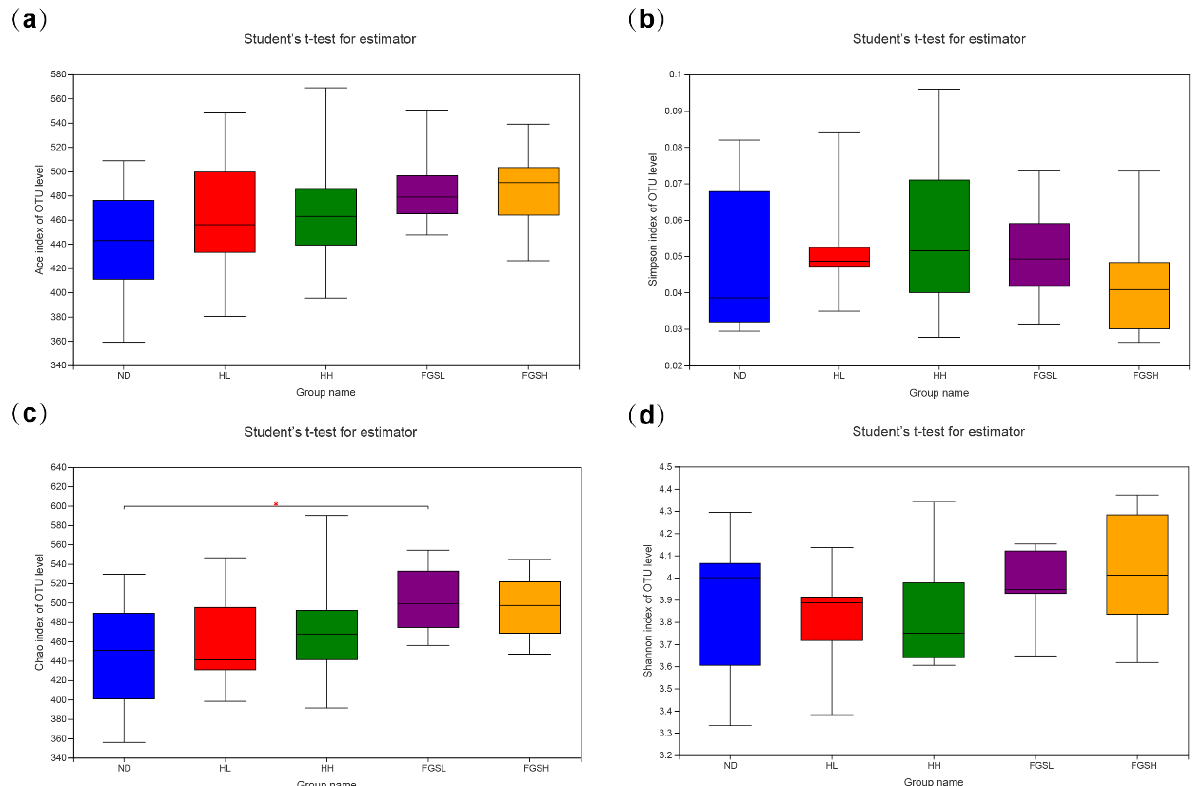
Figure A3. Alpha diversity analysis of intestinal flora in mice. Alpha diversity of Ace ( a ), Simpson ( b ), Chao ( c ), and Shannon indexes ( d ) at the OTU level. Differences in the graph bars were analyzed using one-way ANOVA (* p < 0.05).